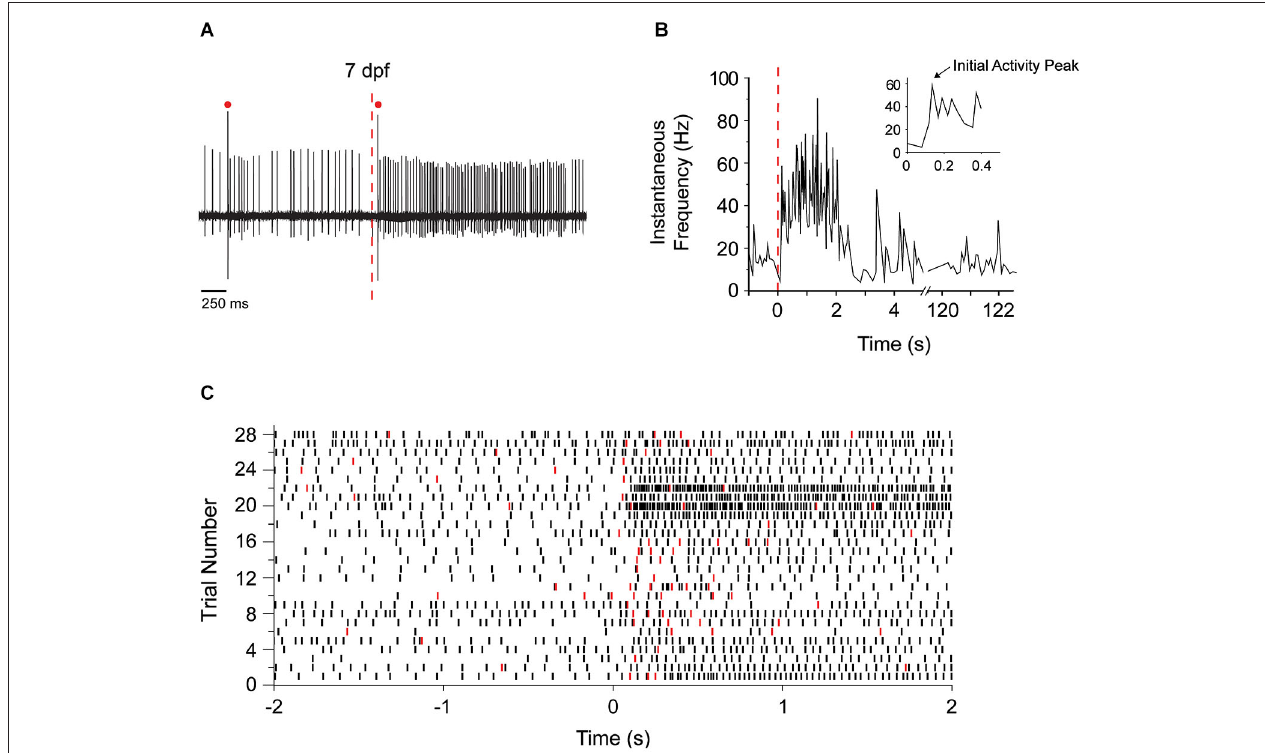
initial peak in firing frequency after the stimulus, which corresponds to the direct response of the Purkinje cell to sudden darkness (see Figure 7 ). (C) Peristimulus raster plot shows the timing of simple action potentials (black symbols) and complex spikes (red symbols) before and after the LED was turned off at time 0. Data were obtained from 28 trials in 11 Purkinje cells from nine animals at 7 dpf. The trace shown in panel (A) corresponds to trial #23. At 7 dpf, the spontaneous tonic firing frequency in the absence of stimulation ranged from 4.5–19.5 Hz (mean ± SEM: 8.8 ± 0.98 Hz, n = 22 cells from 20 animals). After sudden darkness, the peak tonic firing frequency ranged from 19.4–100.7 Hz (mean ± SEM: 40.4 ± 7.4 Hz, n = 11 cells, nine